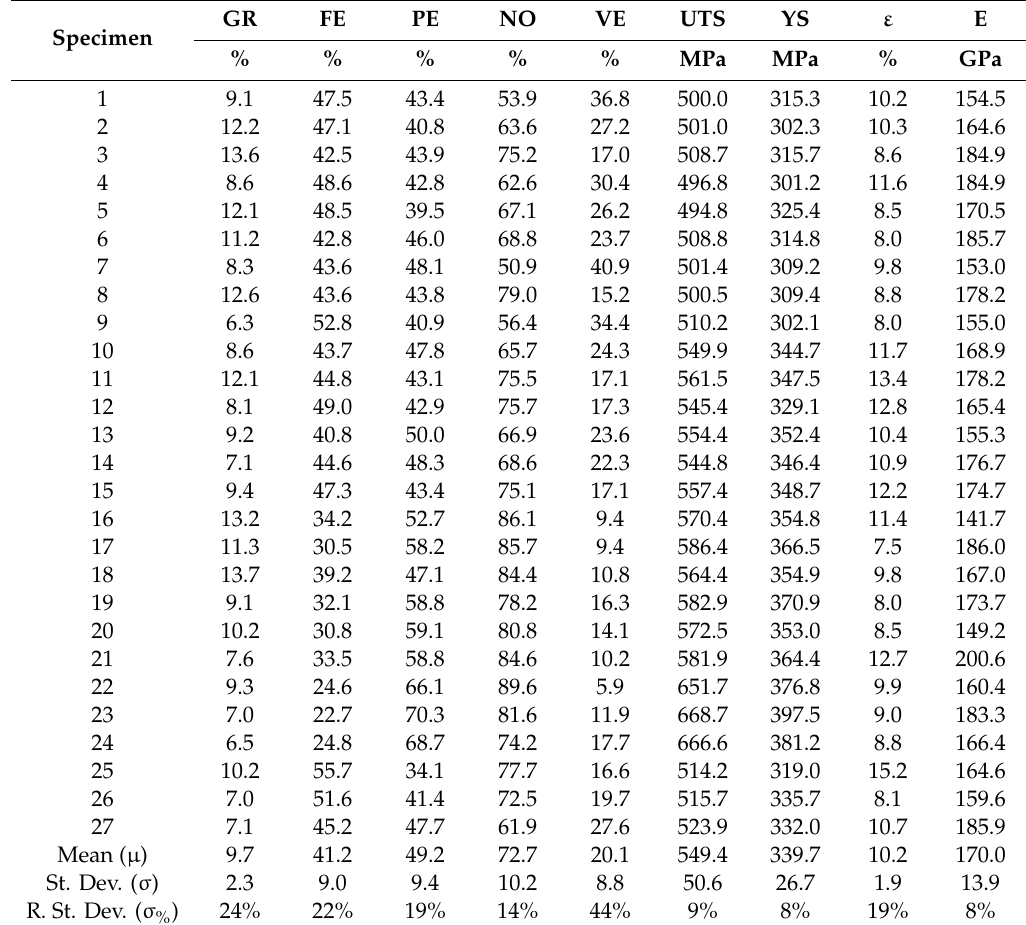
Table A1. Metallographic and mechanical properties of specimens in Spheroidal Graphite Iron (SGI). Data from